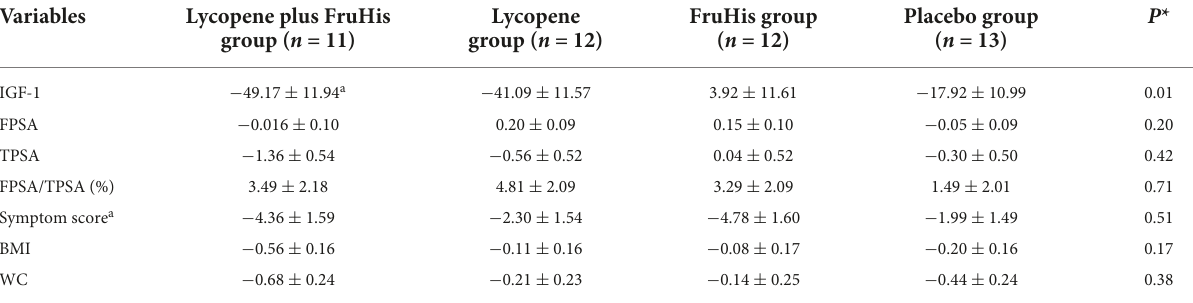
TABLE 4 Adjusted mean changes of outcome variables throughout the trial in the intervention groups.